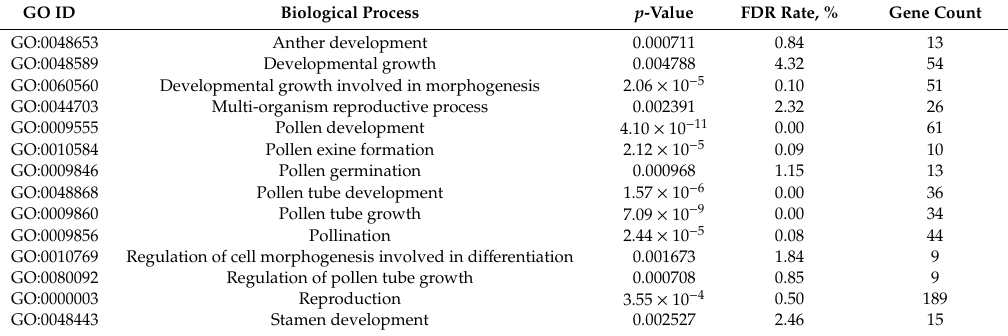
Table 3. Assignment of genes di ff erentially expressed in knl2 flower buds to development-related functional categories based on GO::TermFinder. Genes downregulated in the knl2 flower buds were included into the GO enrichment analysis (cuto ff of 5%